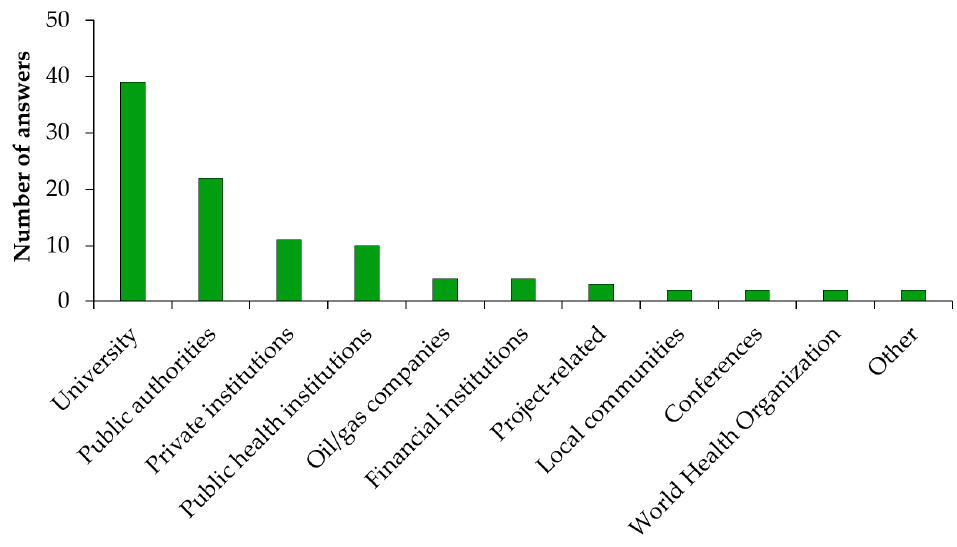
Figure 5. Institutions of HIA teaching and training.